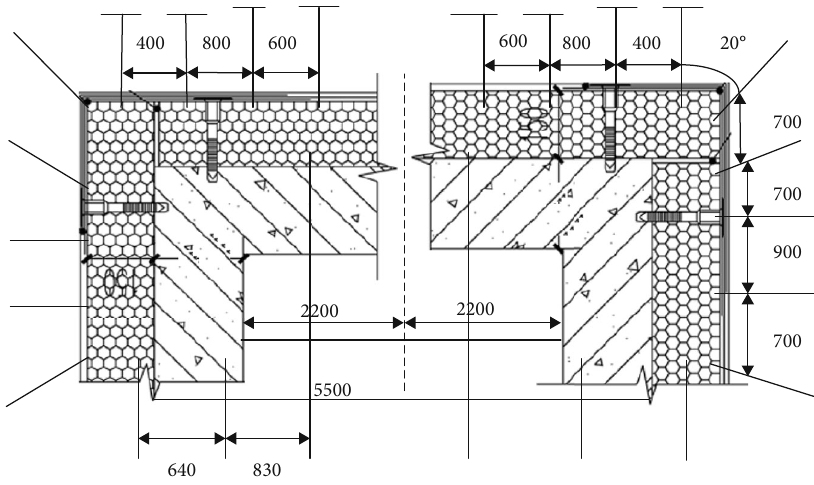
Figure 4: Support plan after optimization of the upper seam roadway.